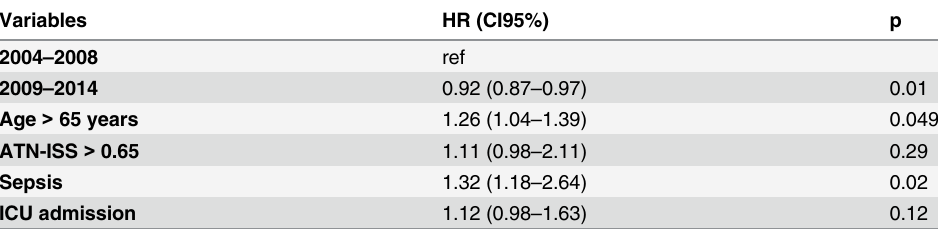
Table 5. Subdistribuition Hazard Ratio of Covariates for technique